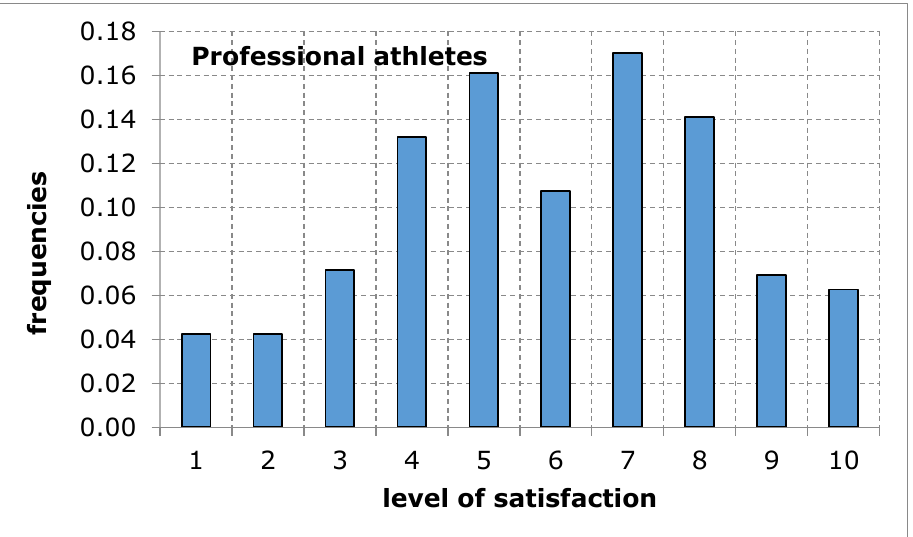
Figure 7. Relatively high prices of services at sports and recreation facilities, in the opinion of service recipients (amateurs). Source: own work.